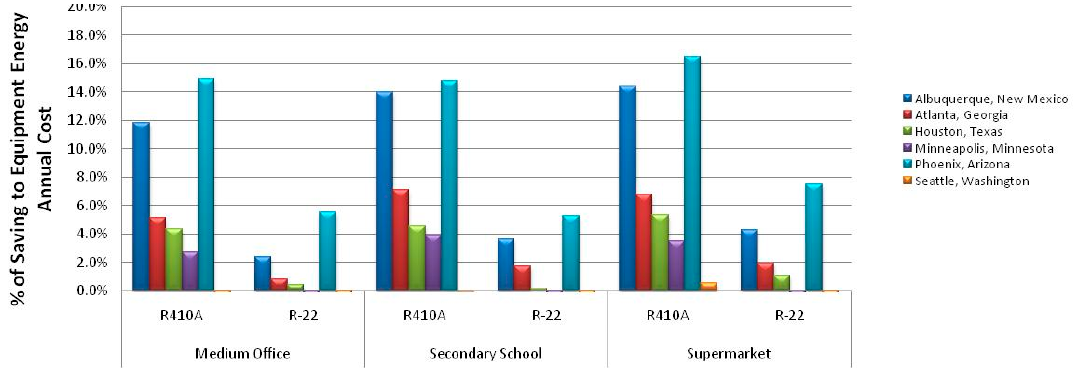
Figure 9. Percentage of energy savings due to pre-cooling relative to no pre-cooling when water is sprayed at all ambient temperatures and wet bulb efficiency of 0.7, and COP = 3.